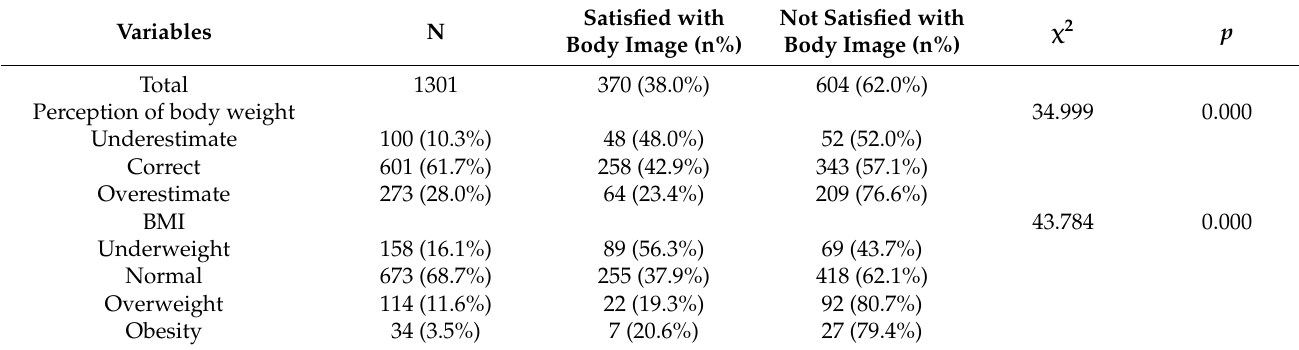
Table A1. Perception of body weight and BMI by satisfaction with body